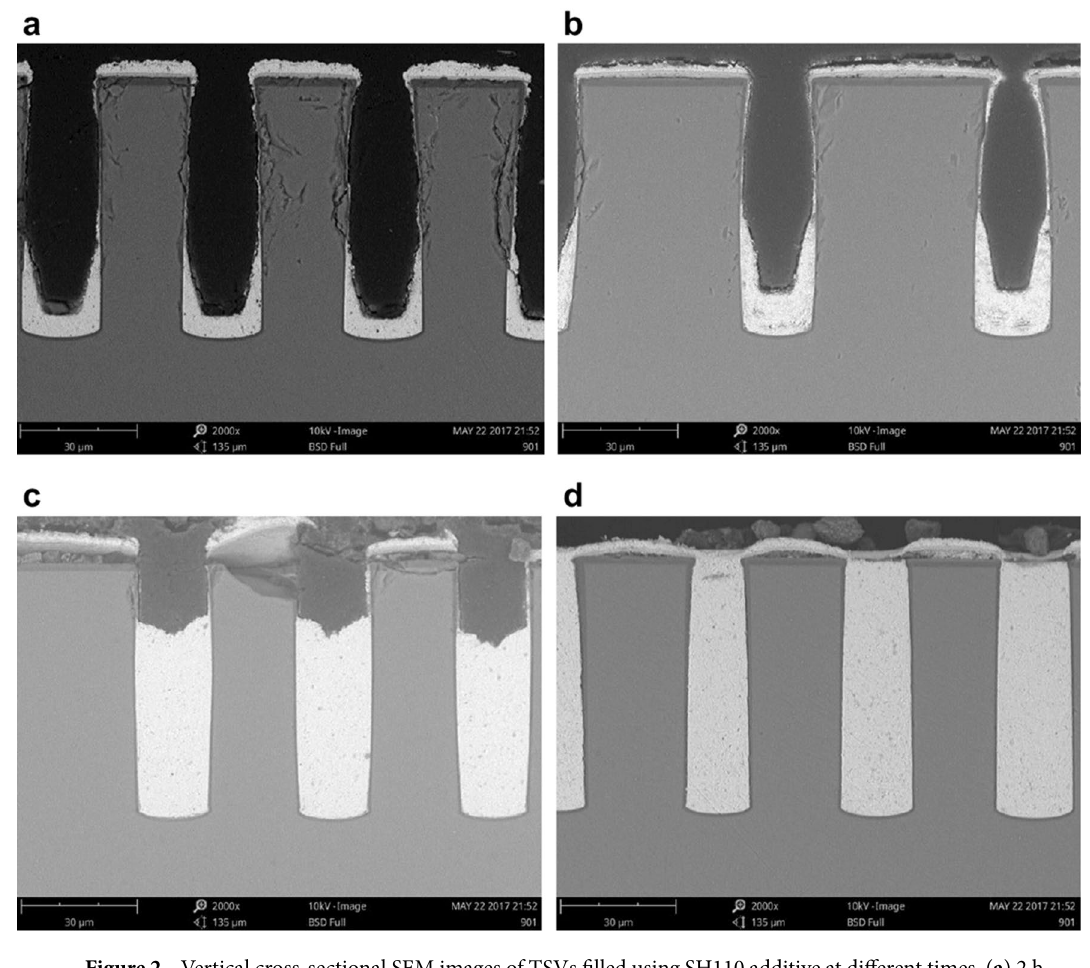
Figure 2. Vertical cross-sectional SEM images of TSVs filled using SH110 additive at different times. ( a ) 2 h, ( b ) 3 h, ( c ) 8 h, and ( d ) 12 h (TESCAN VEGA 3 https:// www. tescan. com/).